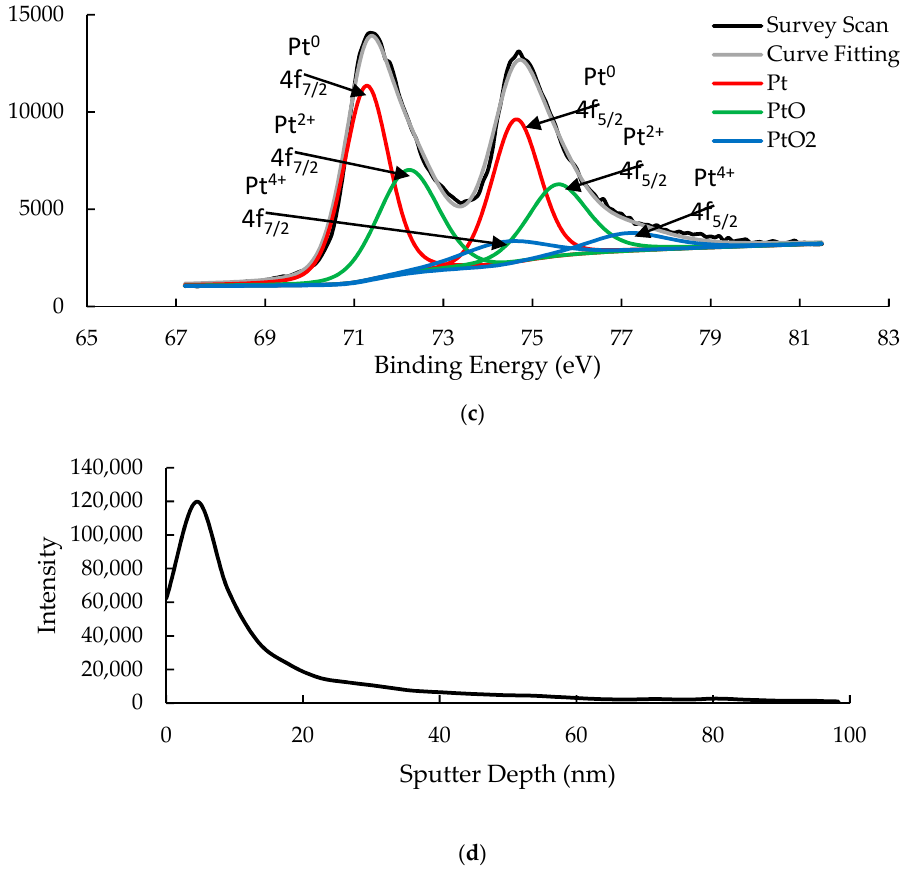
Figure 4. The XPS spectra of Pt-GO-LCM. ( a ) Survey scan. ( b ) Deconvolution of the C1s peak. ( c ) Deconvolution of the Pt4f region. ( d ) Depth profile of the sputtered Pt nanostructures.